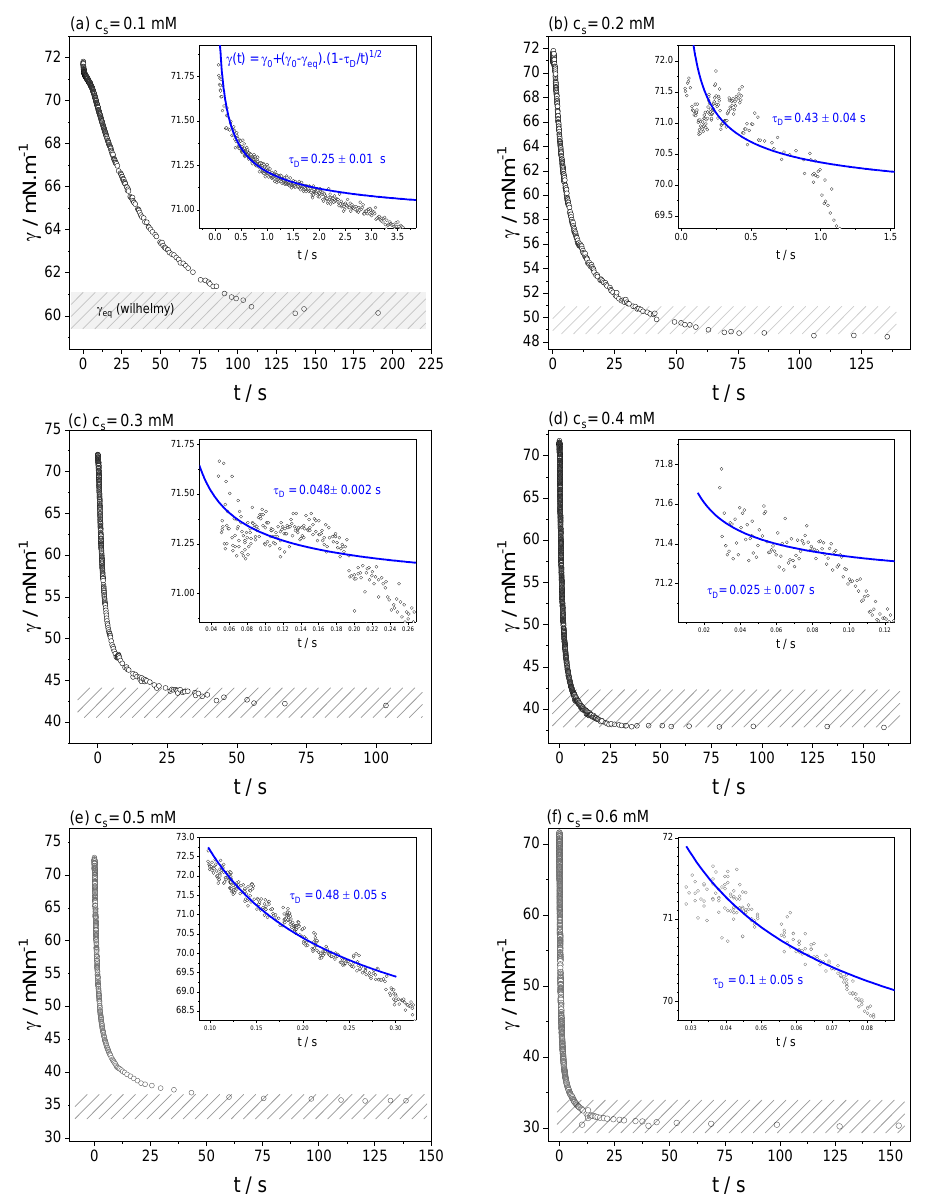
Figure 4. Dynamic surface tension curves for 6 surfactant concentrations well below the cmc ( a ) c s = 0.1 mM; ( b ) c s = 0.2 mM; ( c ) c s = 0.3 mM; ( d ) c s = 0.4 mM; ( e ) c s = 0.5 mM; ( f ) c s = 0.6 mM. The insets are amplifications of the very short adsorption times regions, the curves in them are fittings with Equation (3). The shaded regions represent the equilibrium surface tension (with error) measured by the Wilhelmy plate technique.